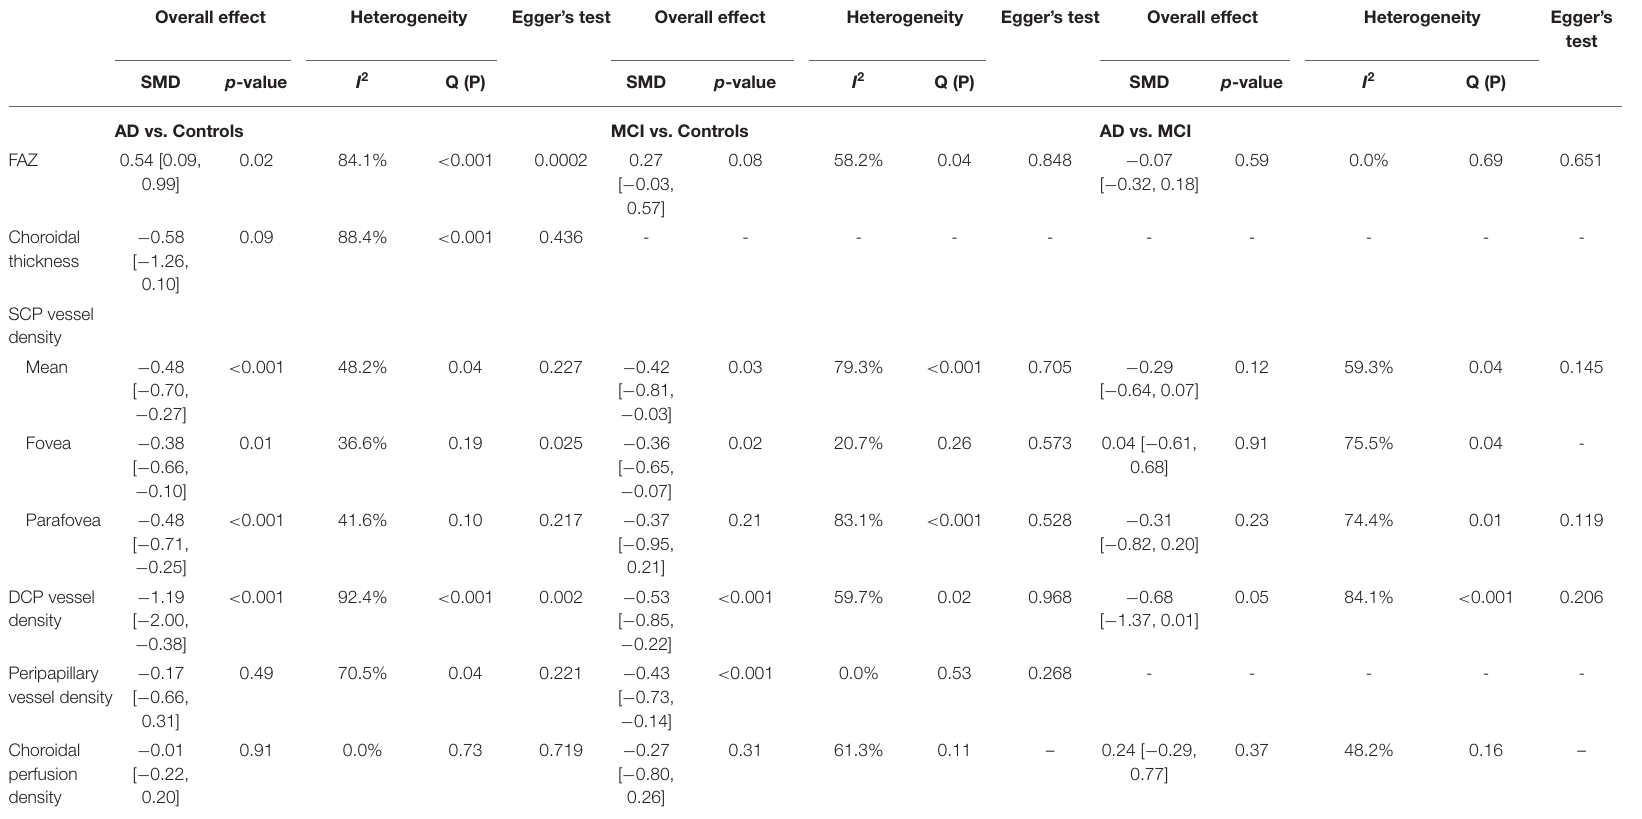
TABLE 4 | Summary of differences of OCTA measurements and risk of publication bias using Egger’s